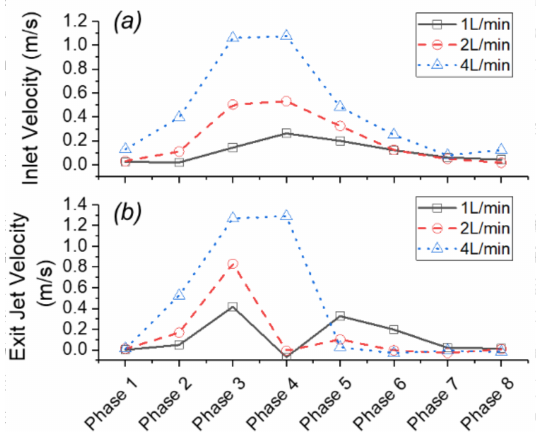
Figure 9. The inlet ( a ) and exit ( b ) jet centerline velocities at different phases under three cardiac